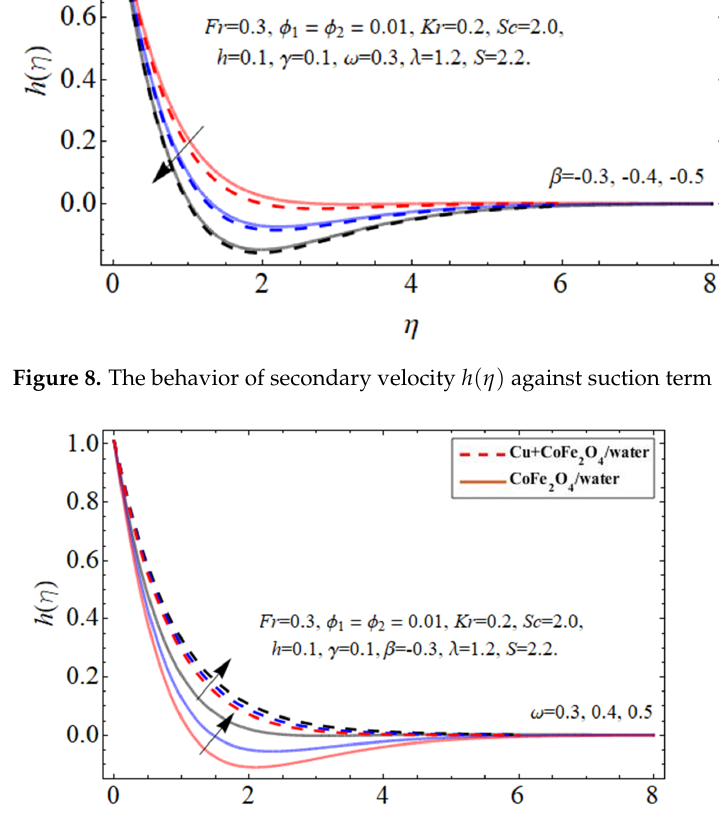
Figure 9. The behavior of secondary velocity h ( η ) against disk term ω